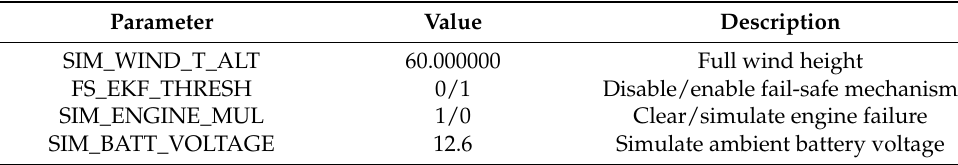
Table 3. Parameter settings in the engine failure simulation.